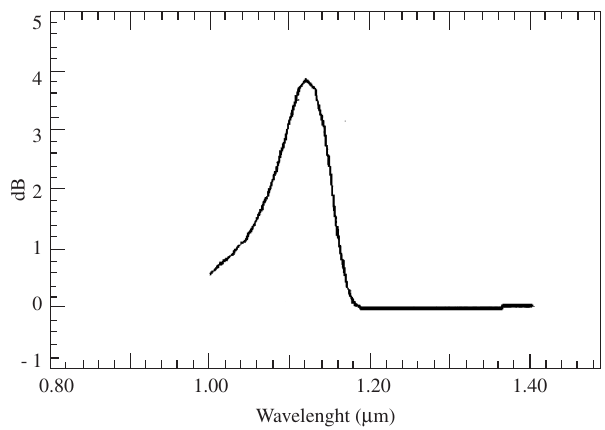
Figure 1. The power spectral cutoff plot using bend reference technique.